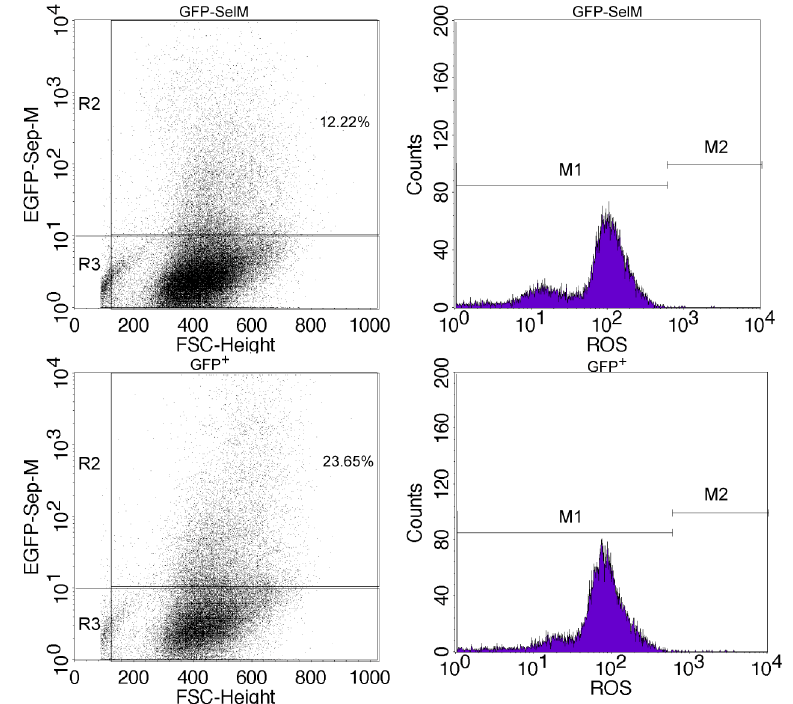
Figure 4. The relative inhibition rate of ROS in the cells transfected with pSelExpress1- GFP-SelM under 0.5 μ mol/L Na ( 2 ) pSelExpress1- GFP-SelM ′ under 0.5 μ mol/L Na